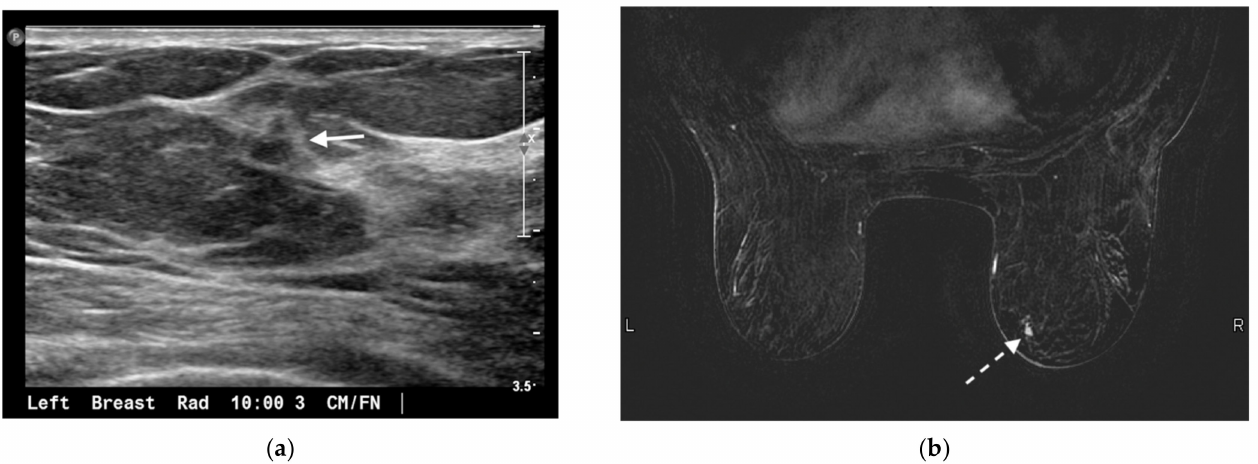
Figure 2. 75-year-old woman presented for annual screening evaluation. Mammogram demonstrated a left breast asymmetry (not shown) which prompted further workup. ( a ) Left breast ultrasound in radial projection at the 10 o’clock axis 3 cm from the nipple demonstrates a suspicious 0.5 × 0.6 × 0.4 cm hypoechoic antiparallel mass with irregular margins and posterior acoustic shadowing (arrow), corresponding to the mammographic abnormality. Ultrasound guided biopsy yielded invasive ductal carcinoma, mucinous type. ( b ) MRI was performed to evaluate the extent of disease; axial contrast-enhanced T1-weighted fat-suppressed image demonstrates a separate 0.7 × 0.5 cm enhancing irregular mass in the lower inner quadrant of the contralateral right breast (dashed arrow). This was biopsied under MRI guidance and yielded invasive ductal carcinoma, mucinous type. The known left breast cancer is not